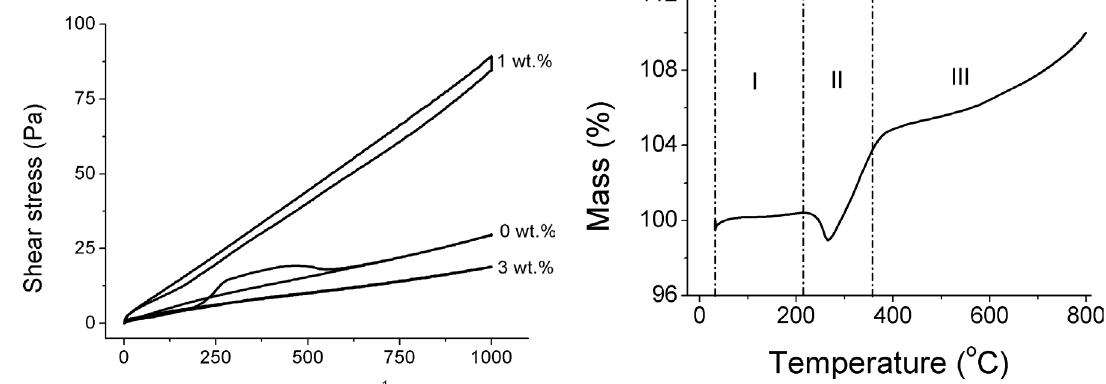
Figure 4. TG result for a copper green tape with 3.0% of binder in air